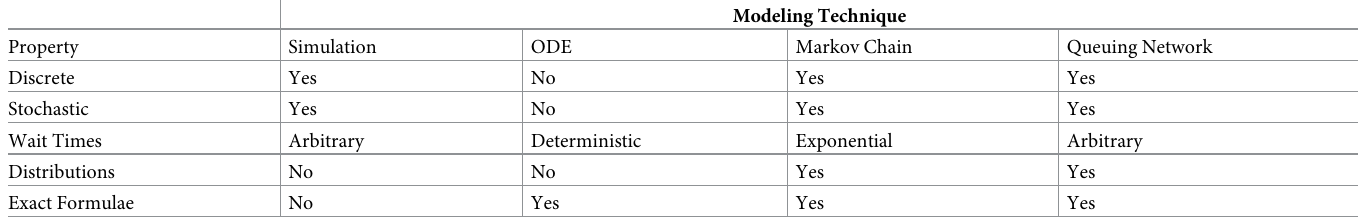
Table 2. Summary Comparison of Modeling